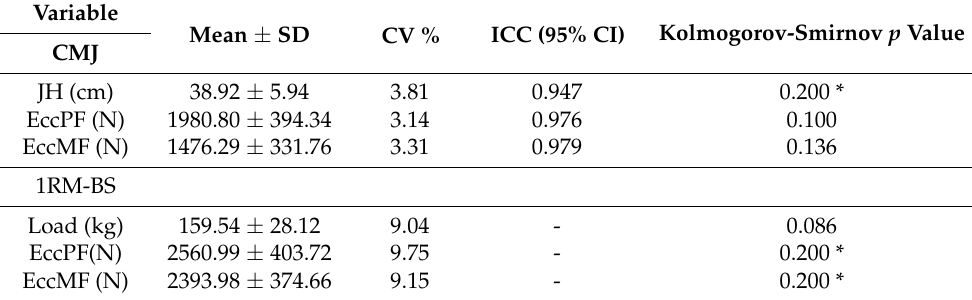
Table 1. Mean ± standard deviations (SD), coefficients of variation (CV), Kolmogorov-Smirnov normally distributed CMJ and 1RM-BS measures, with 95% confidence intervals (CI), intraclass correlation coefficients (ICC) for the CMJ.